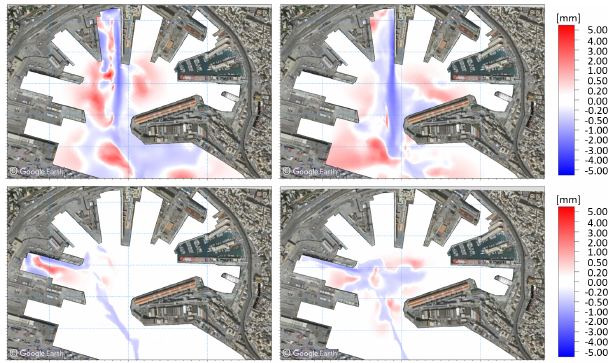
Figure 11. Erosion and deposition maps resulting from one depar- ture (left column) and one arrival (right column) of the represen- tative passenger vessels of docks 1012 (top row) and T7 (bottom row). Land background from © Google